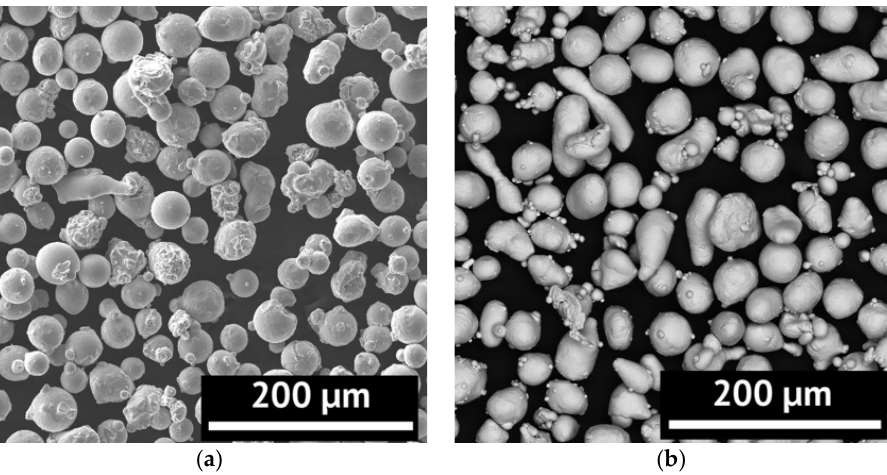
Figure 1. Particle morphology of the initial Inconel 718 ( a ) and yttrium ( b ) powder particles. The morphology of the powder was studied using a scanning electron microscope (SEM, Tescan Mira 3).